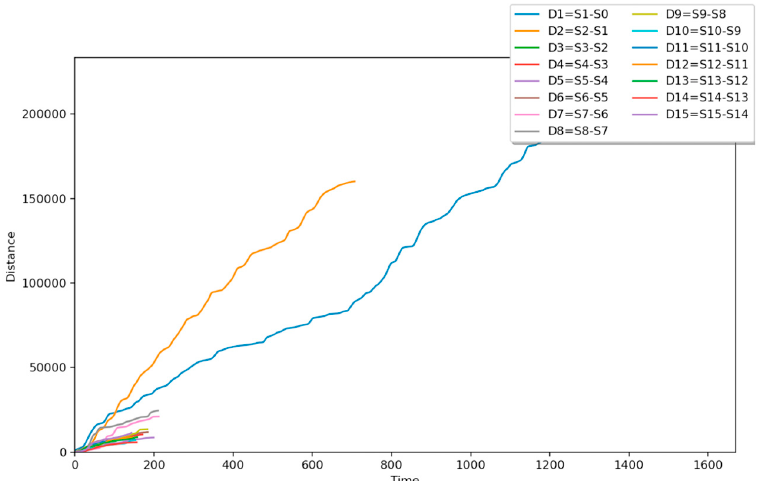
Figure 5. ( a ) Time taken to complete each of 16 conducted sessions for user number 82; ( b ) Average mouse movement speed for each of 16 conducted sessions.